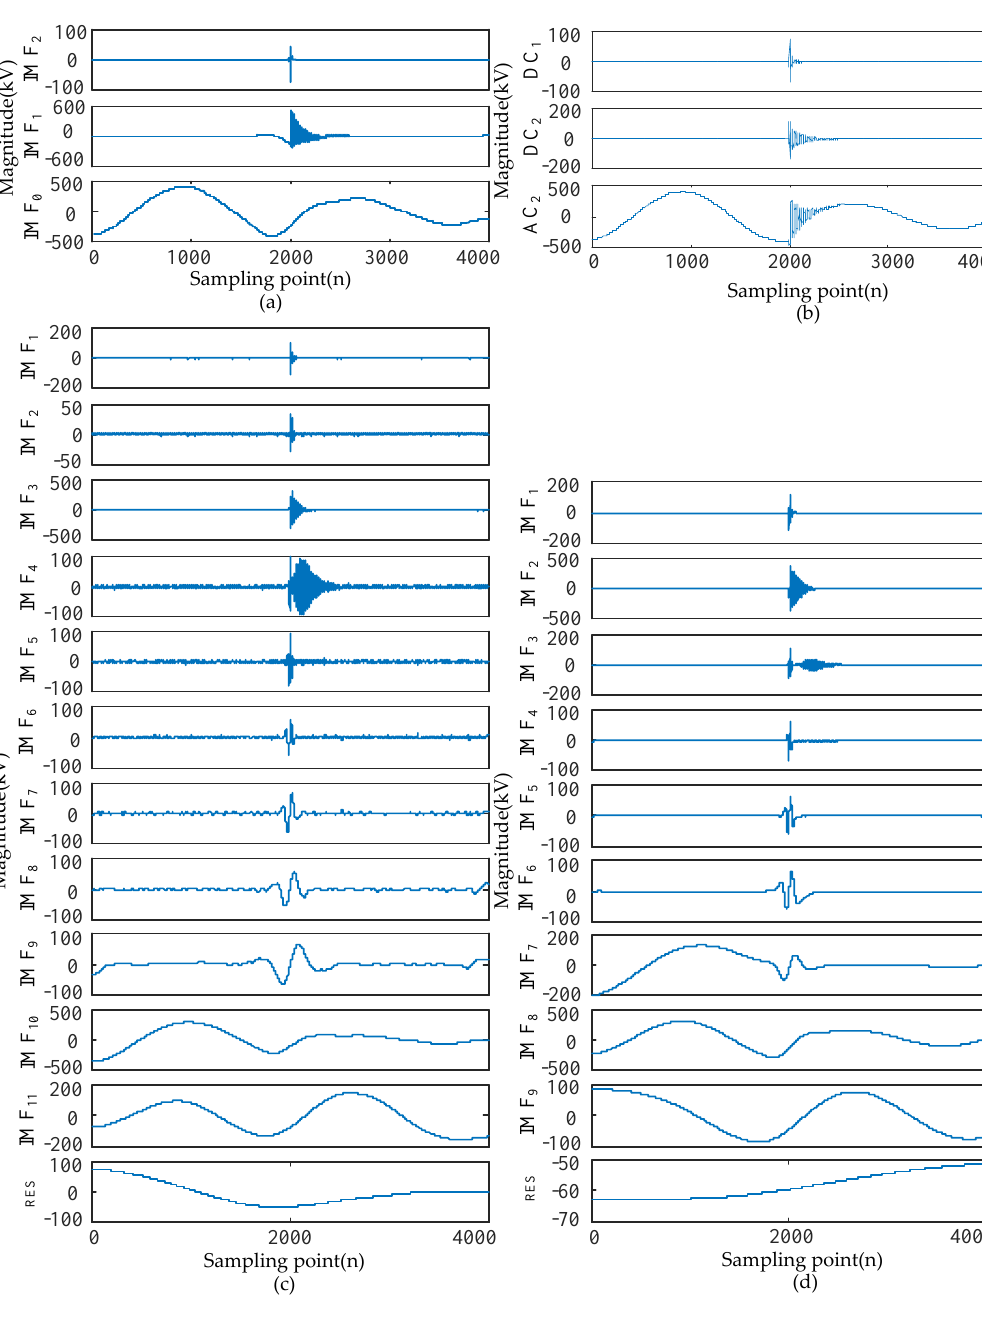
Figure 4. Comparison experiments of different signal processing methods for fault signal analysis are shown as follows: ( a ) modes extracted by EWT; ( b ) modes extracted by WT; ( c ) modes extracted by CEEMDAN; ( d ) modes extracted by Improved CEEMDAN.